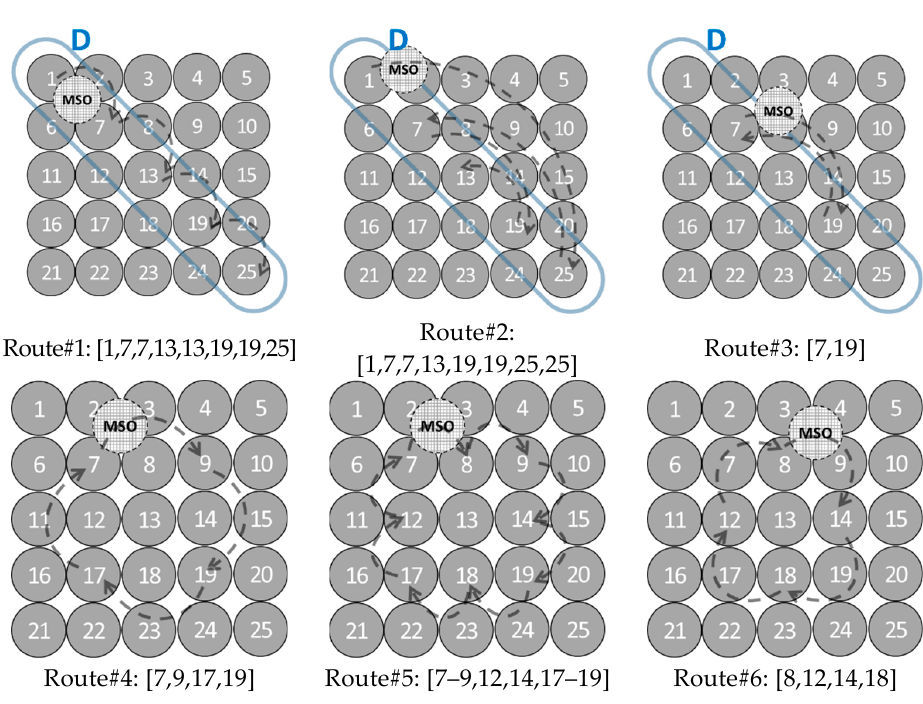
Figure 2. Different routes for N = 25 lattice topology.